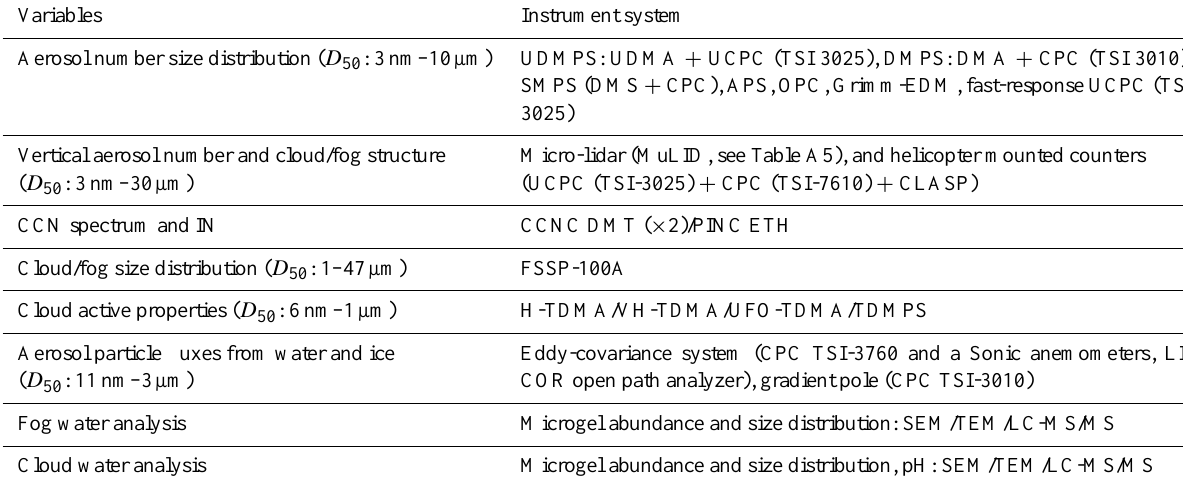
Table A8. Atmospheric aerosol – physical and cloud active properties. Variables